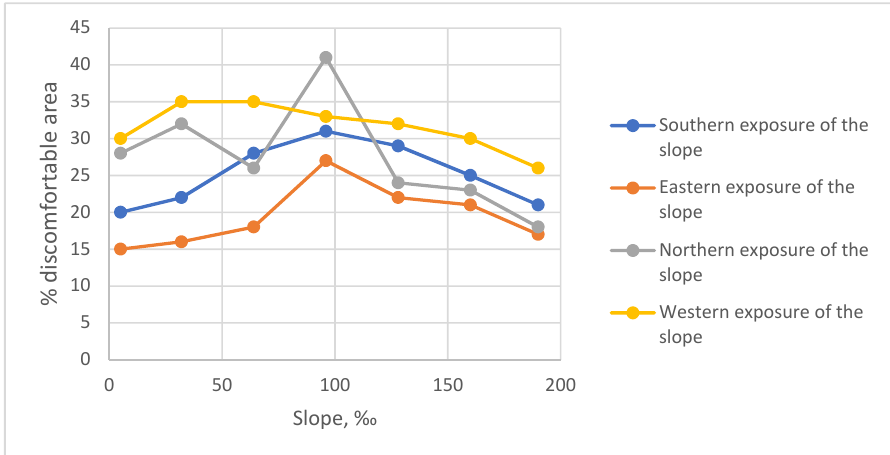
Figure 12. The dependence of k on the slope gradient for the perimeter type of development. Buildings 2022 , 12 , x FOR PEER REVIEW